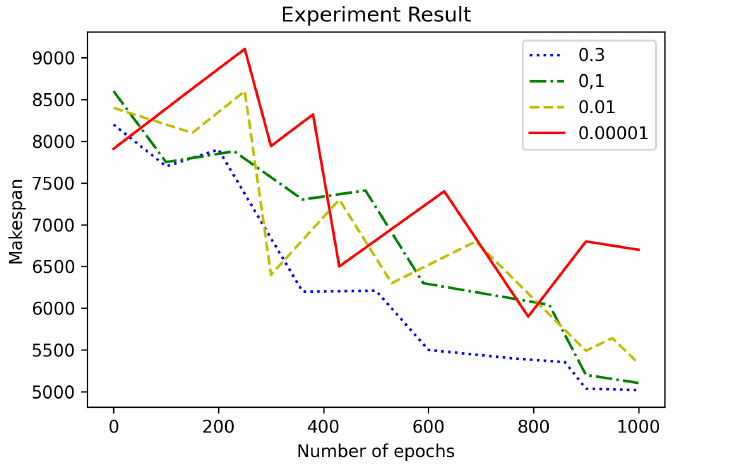
Figure 5. Convergence analysis according to the number of M and J.